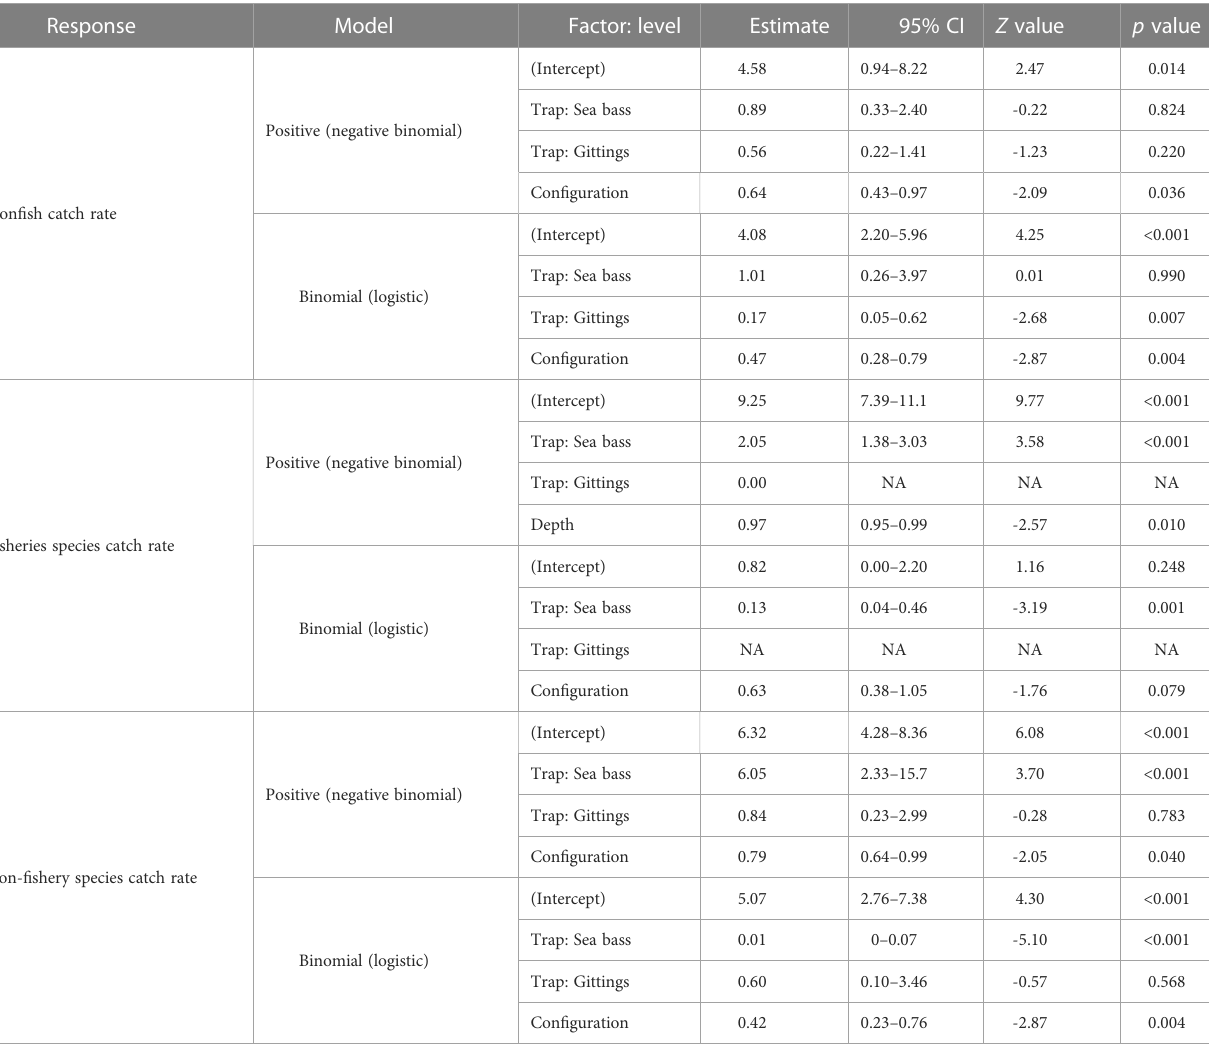
TABLE 2 Zero-in fl ated negative binomial (ZINB) model results assessing the effects of trap deployment and reef site factors on catches of lion fi sh, fi sheries species, and non- fi sheries